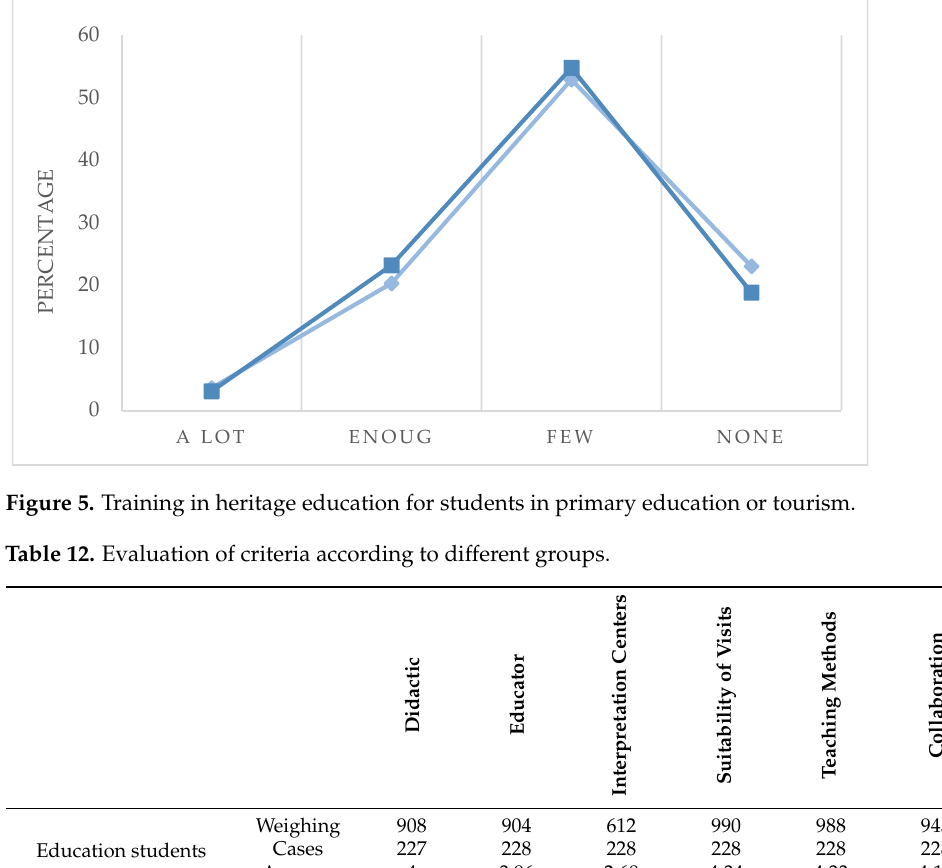
Table 12. Evaluation of criteria according to different groups.